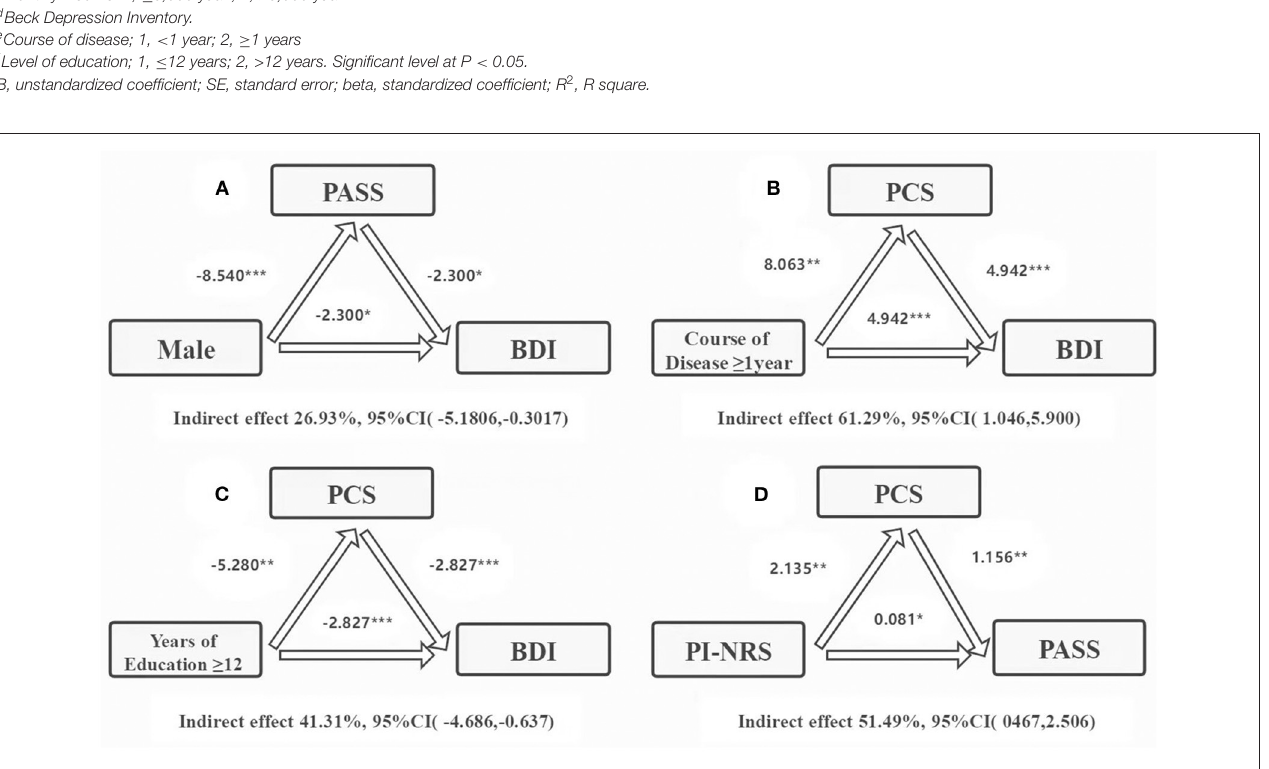
FIGURE 2 | Mediation analysis of the role of pain-related anxieties and pain catastrophizing thoughts in mediating the relationship between male, course of disease ≥ 1 year, years of education ≥ 12, depressive symptoms, and pain intensity. PASS, Pain Anxiety Symptoms Scale; PCS, Pain Catastrophizing Scale; PI-NRS, pain intensity numerical rating scale; * P ≤ 0.05; ** P ≤ 0.01; *** P ≤